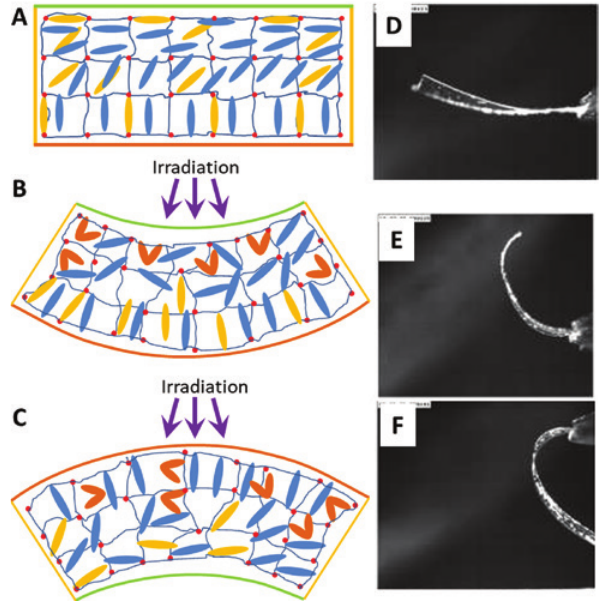
Figure 23: The bending behavior of an azo-LCE film with splayed alignment. (A) Illustration of the molecular arrangement. If the film is irradiated exposing the surface (green) with planar alignment, the film bends upward (B). On the contrary, if the surface exposed has homeotropic alignment (orange), the film bends downward (C). (D–F) Experi- mental bending behavior of an azo-LCE film with splay alignment showing increased bending in respect to a fully planar film (D) and the inversion of the bending direction if illuminated at planar (E) and homeotropic (F) sides. (D–F) Adapted with permission from [316], copyright 2007, Springer Nature.